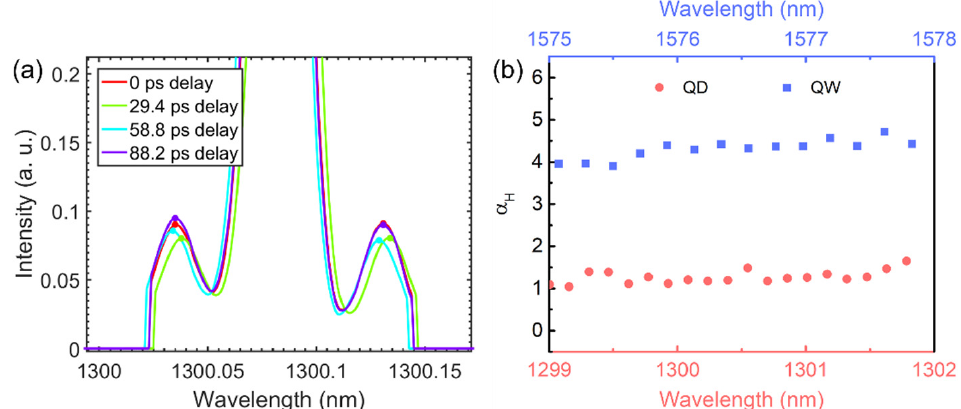
Figure 10. ( a ) Normalized spectra of one longitudinal mode under four delays for the QD laser; ( b ) spectral dependence of the α H -factor measured for both QD (red) and QW (blue) lasers.